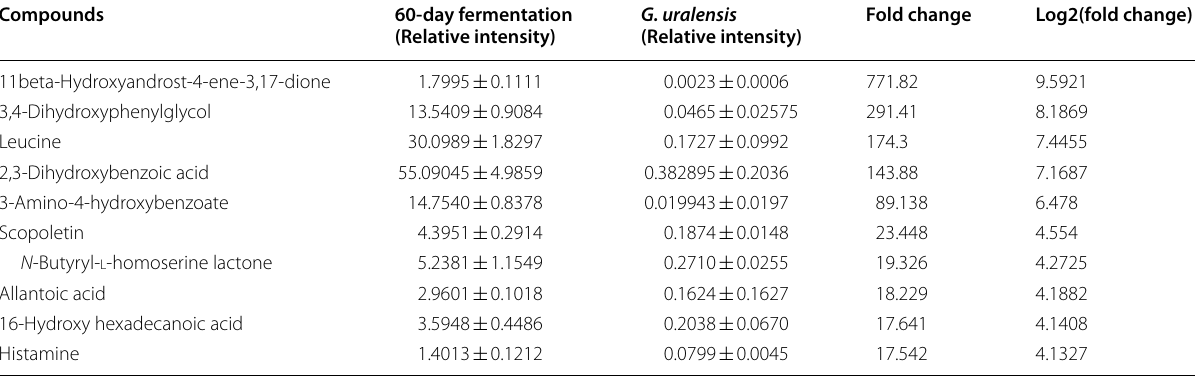
Table 2 The metabolites using LC/MS analysis with most increase after the 60‑day G. uralensis fermentation by M. ruber BCRC 31,535